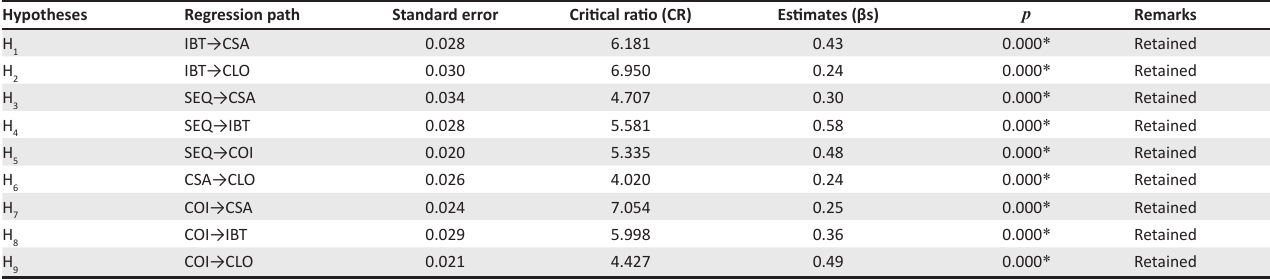
TABLE 9: Regression path estimates. Hypotheses Regression path Standard error Critical ratio (CR) Estimates (βs)